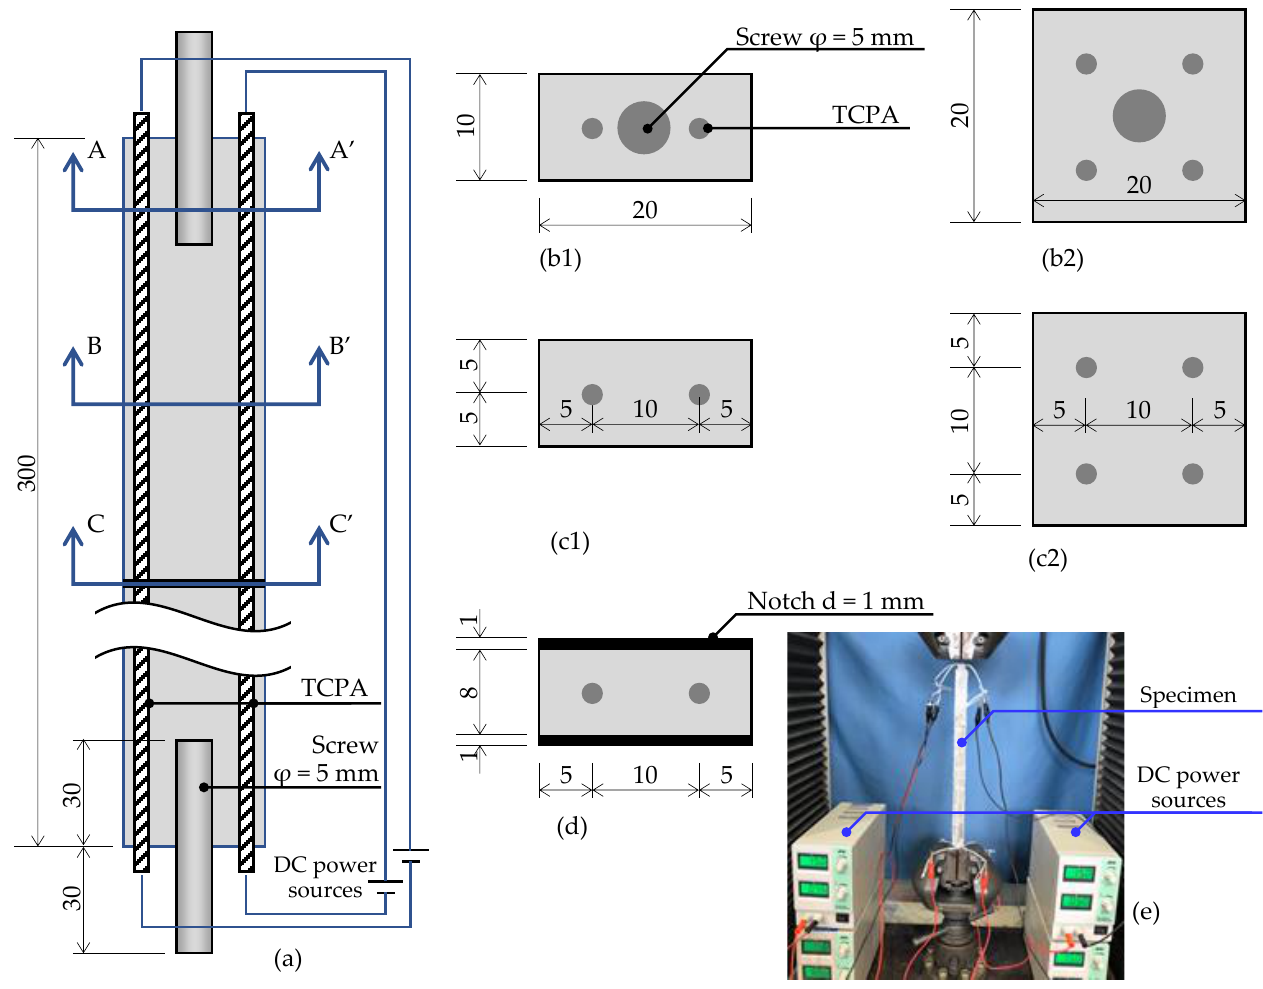
Figure 3. Set-up of uniaxial tension test with embedded TCPA. ( a ) Drawing of Specimen. ( b1 ) A-A’ section for Test A and C . ( b2 ) A- A’ section for Test B . ( c1 ) B- B’ section for Test A and C . ( c2 ) B-B’ section for Test B . ( d ) C- C’ section for Test C . ( e ) Test setups for Test B.